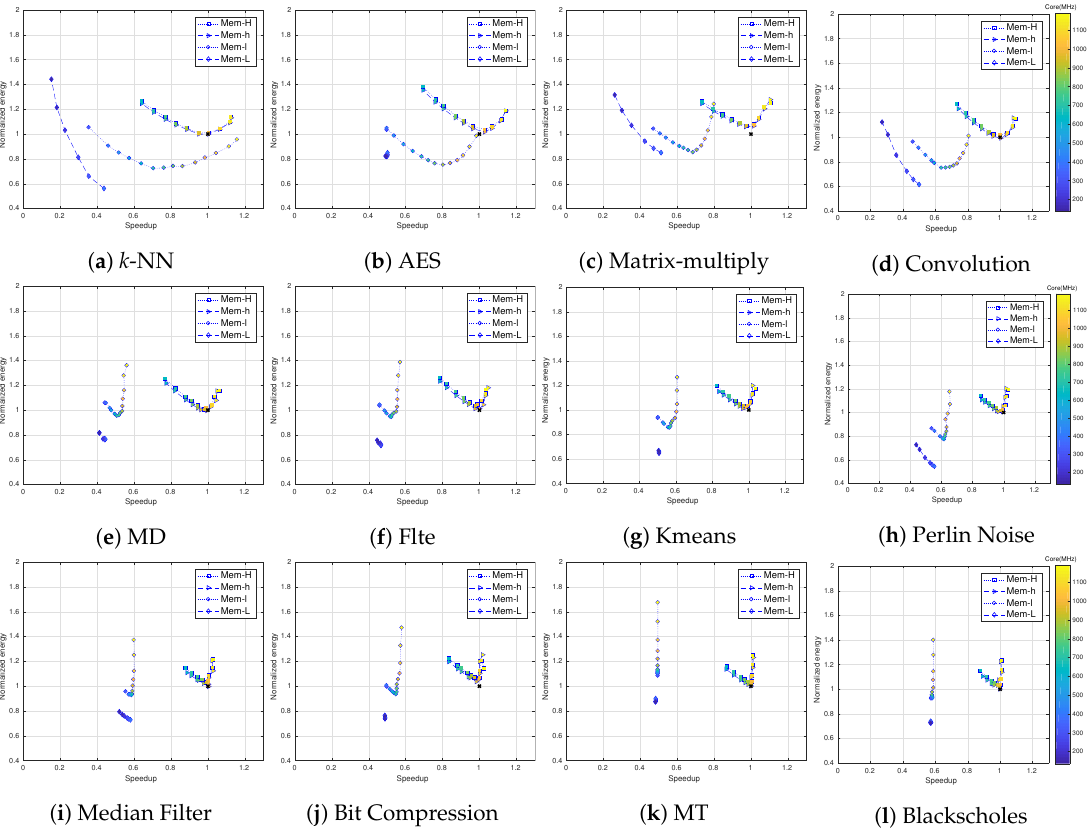
Figure 9. Speedup and normalized energy for twelve selected benchmarks and different frequency configurations as in Fan et al. [3]. Bottom (energy)-right (speedup) is